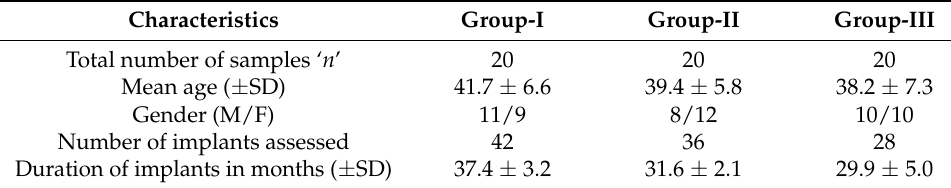
Table 1. Demographics of the study groups.